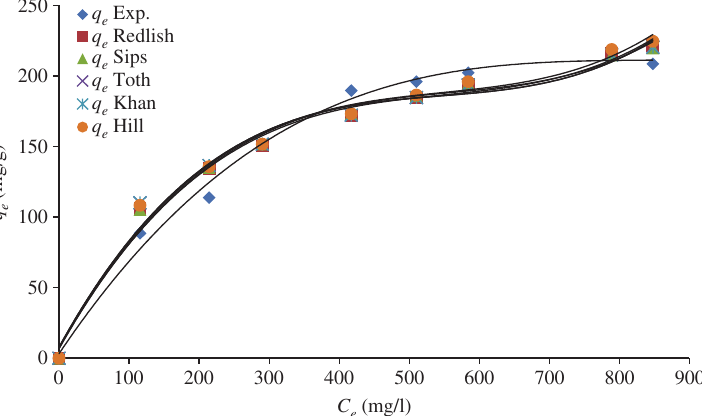
Figure 6: Comparison of three-parameter isotherm models with experimental data of Pb(II) onto S. sesban L. at 30 ° C.